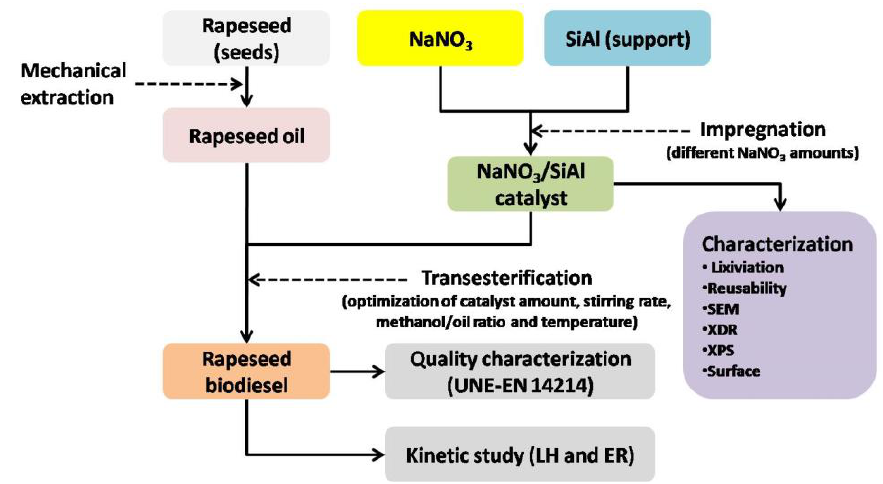
Figure 1. Experimental design.